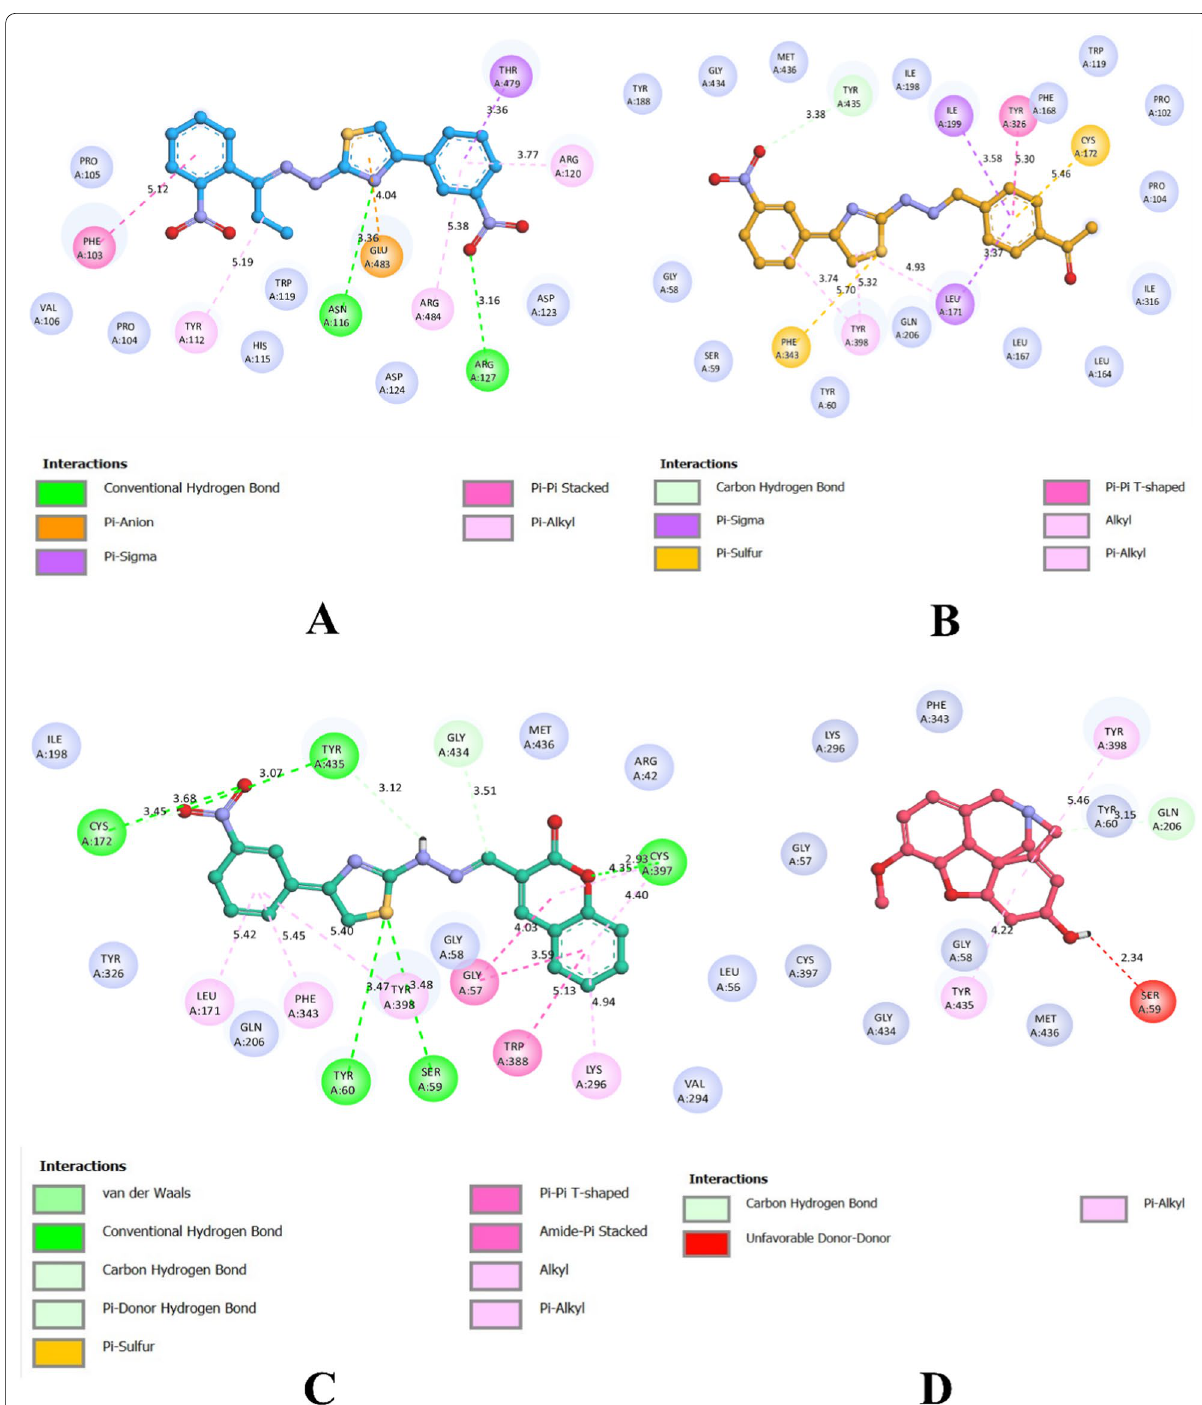
Fig. 9 Binding interactions of compounds with the protein in 2D view: A compound 13, B compound 31, C compound 33, and D Eldepryl (reference). Lavender: surrounding residues, colored: binding